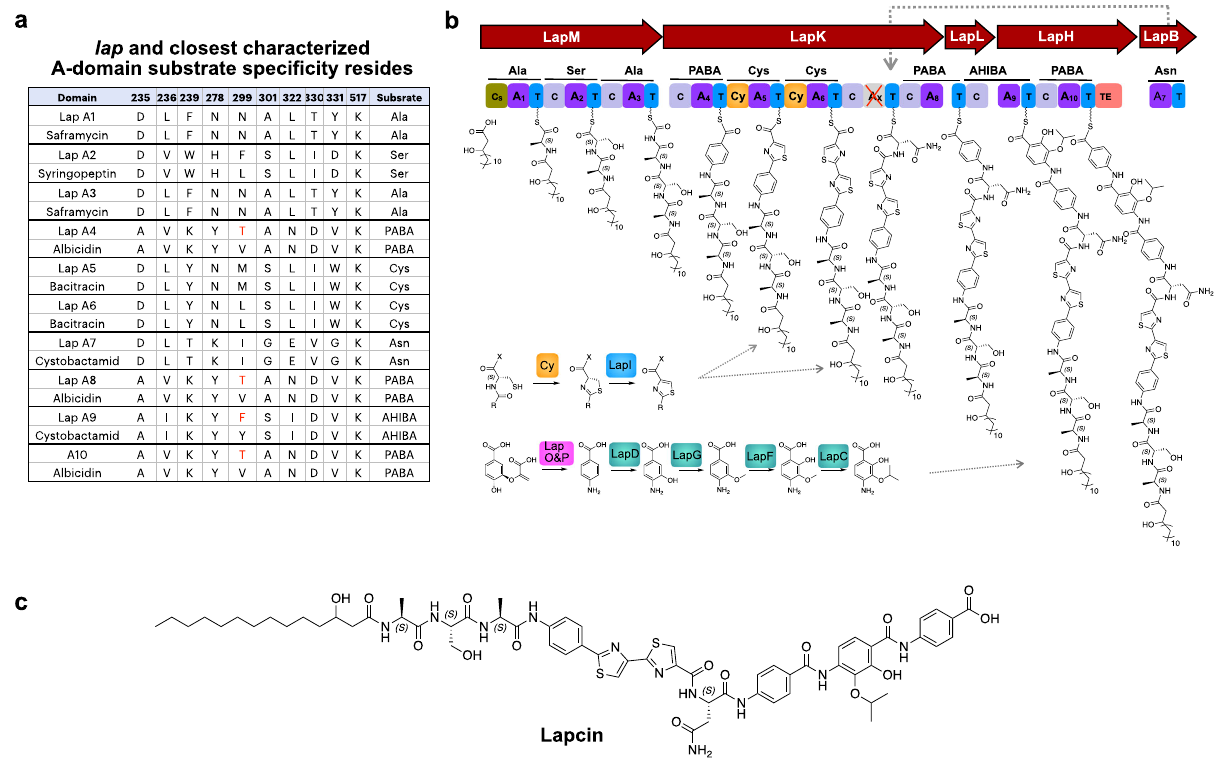
Fig. 2 Bioinformatic prediction of lapcin from the lap gene cluster. a The substrate of each lapcin A-domain was inferred by comparing the 10 residues that make up the substrate binding pocket of each lapcin A-domain with characterized NRPS A-domains (red, difference between lap and known substrate binding pockets). b The structure of lapcin was predicted bioinformatically based on the NRPS modules and accessory enzymes found in the lap gene cluster. c The predicted structure of